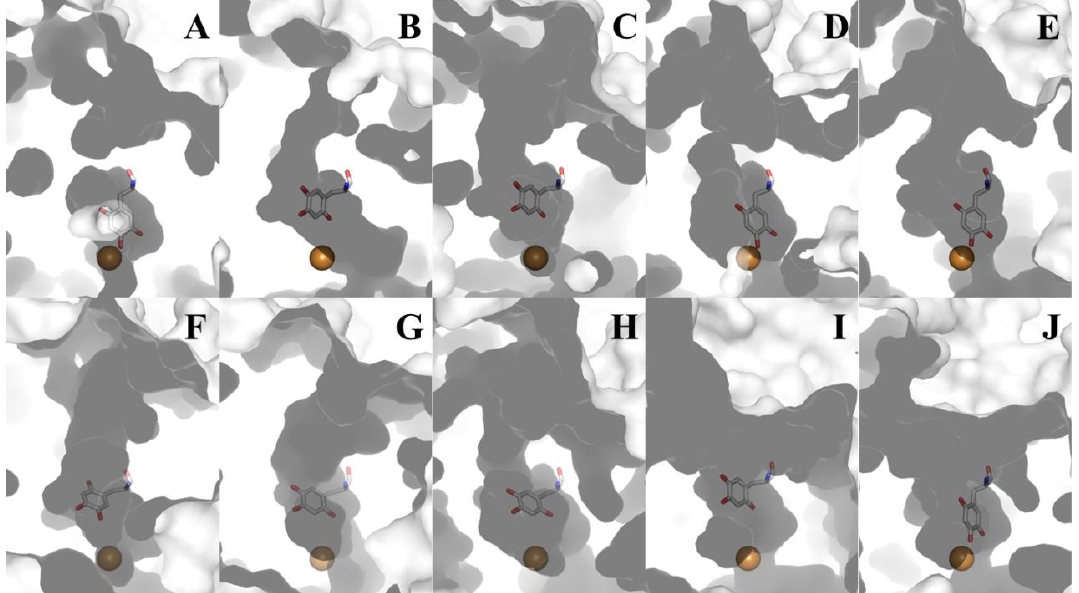
Figure 11. Cross-section through the amine substrate channels of different CAOs. Each enzyme is drawn as a molecular surface. TPQ is drawn in stick and colored by atom type (carbon, white). Copper ions are drawn as gold spheres. ( A ) ECAO; ( B ) HPAO-1; ( C ) HPAO-2; ( D ) VAP-1; ( E ) DAO; ( F ) PSAO; ( G ) AGAO; ( H ) BSAO; ( I ) ANAO; ( J ) PPLO (Table